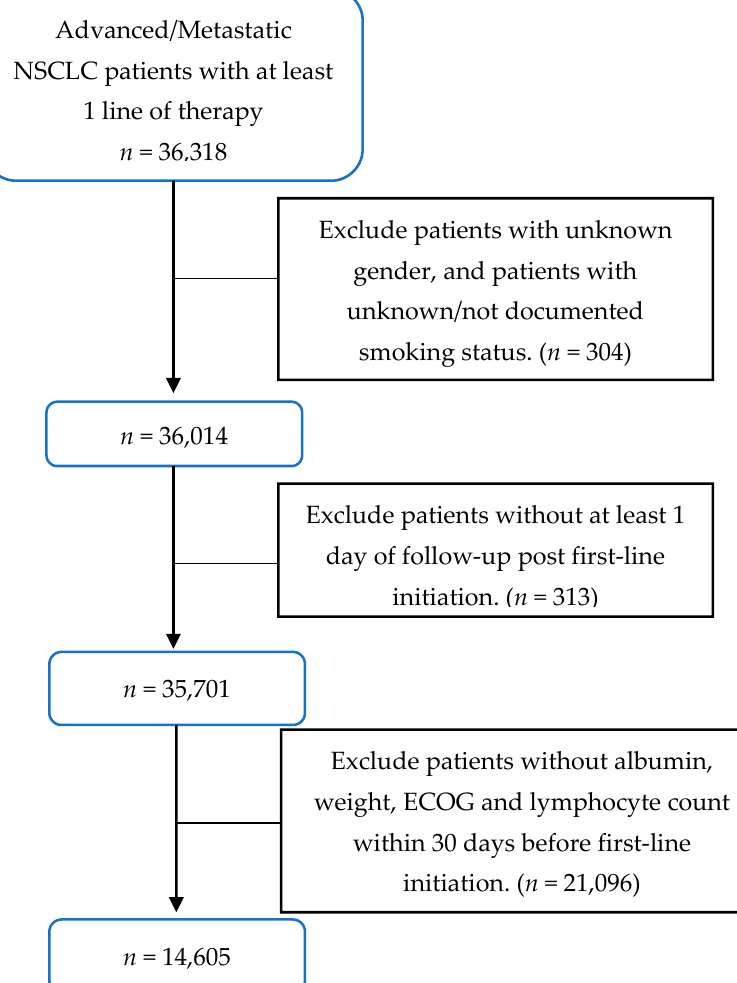
Figure A1. Distribution of spline basis functions based on landmarks. Figure A2. Flowchart of the data cleaning Figure A2. Flowchart of the data cleaning approach.